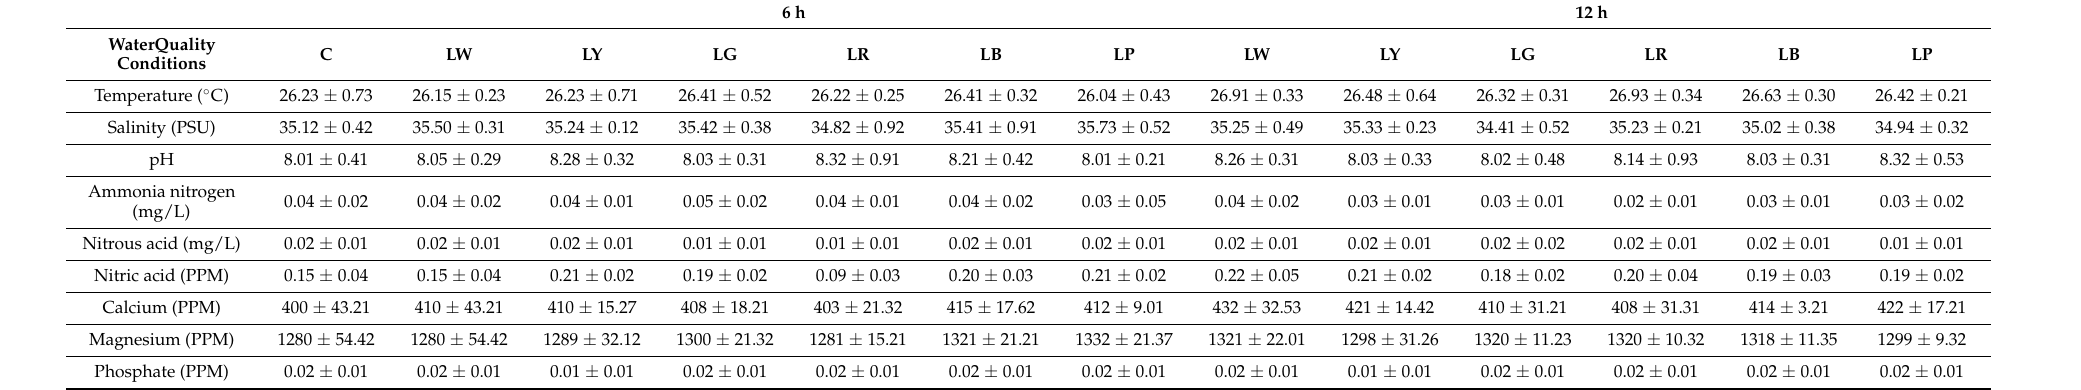
Table 2. Water quality